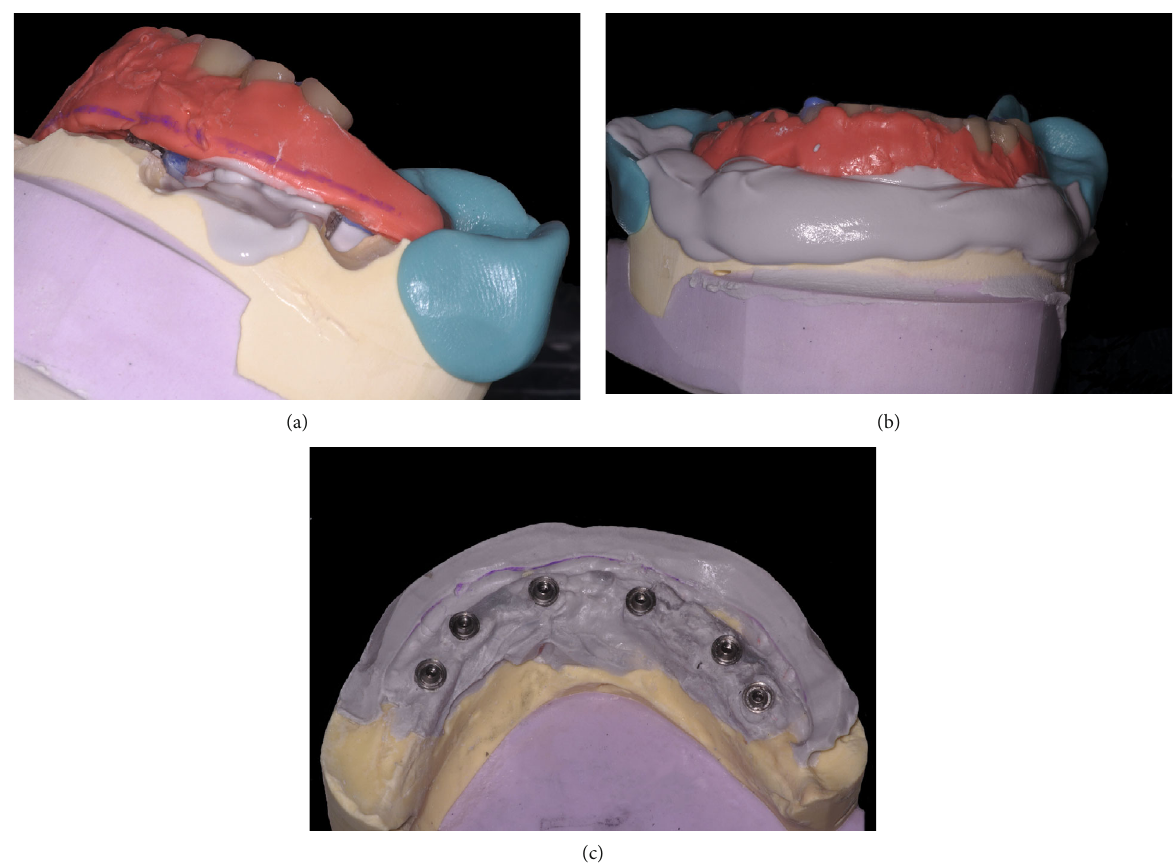
Figure 6: Master cast model modi fi cation. (a, b) New dental stone is poured into the space conserved on the buccal side. (c) Master cast model with the new crest anatomy.